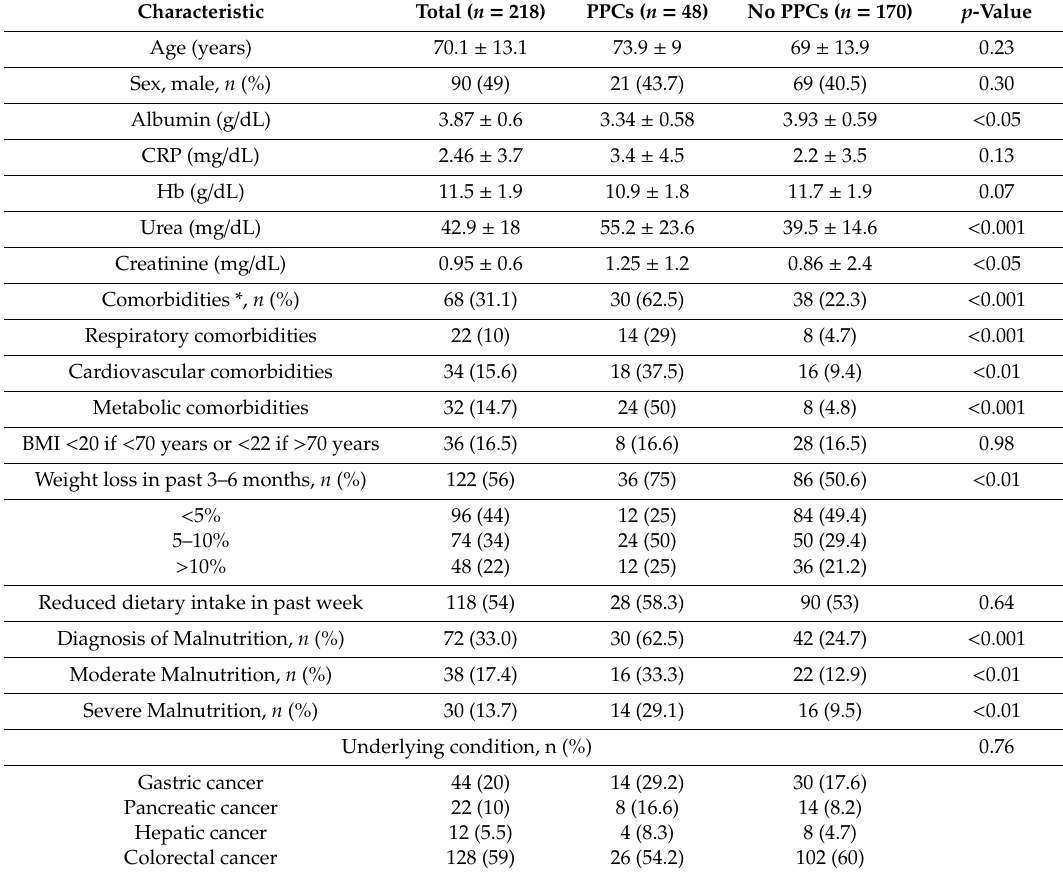
Table 1. Patients demographics, baseline and postoperative characteristicsaccording to postoperative pulmonary complications occurrence